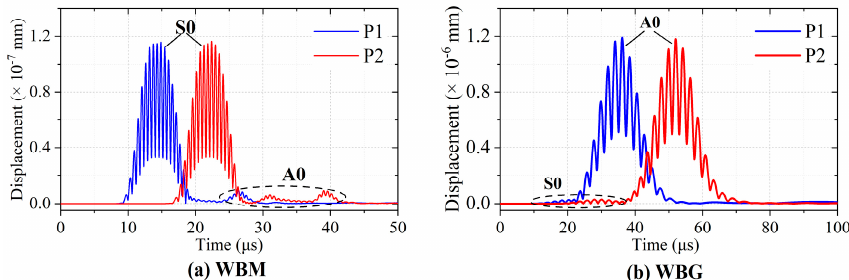
Figure 14. Total displacements at P1 and P2 of the WBM and WBG